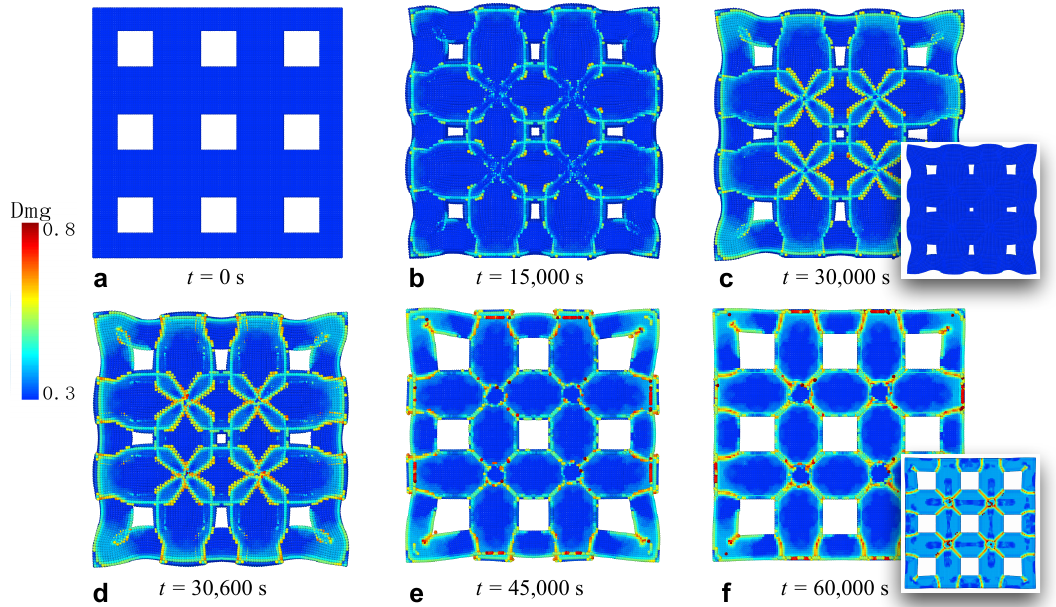
Figure 5. The process of crack formation and propagation in the silicon film pattered with square holes. The holes are located at 25 µ m, 75 µ m, and 125 µ m in each direction from the corners. The width of the holes is 25 µ m. The figures and the insets correspond to the same process of lithiation/delithiation as in the continuous